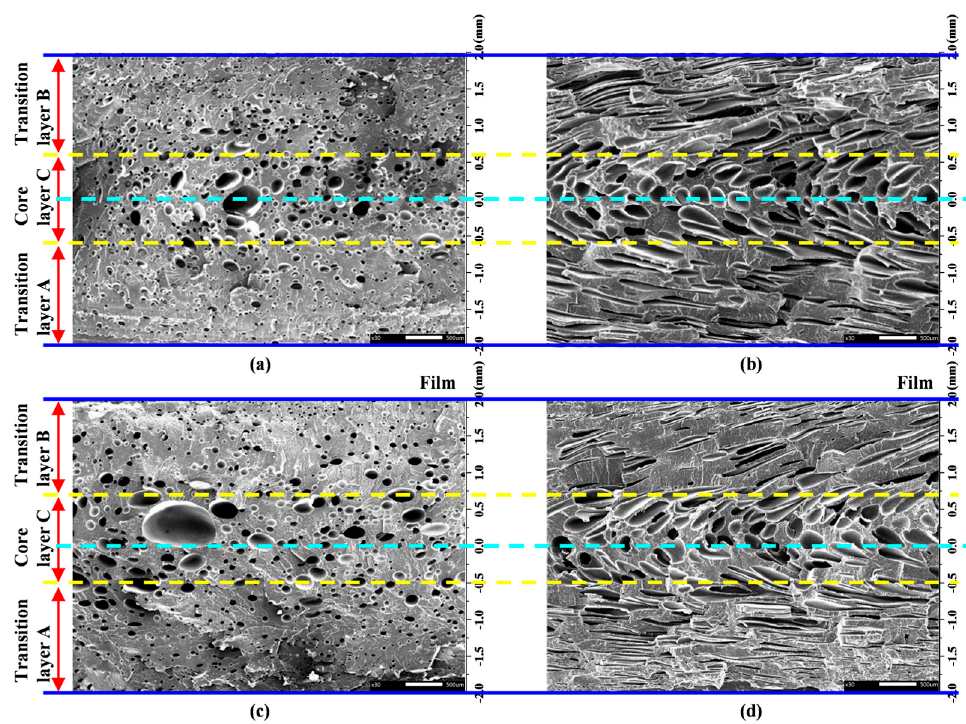
Figure 13. Layered schematic diagram: ( a ) and ( b ) layered schematic diagram of vertical section and parallel section of the MIM sample, respectively; ( c ) and ( d ) layered schematic diagram of vertical section and parallel section of the IMD/MIM sample, respectively.